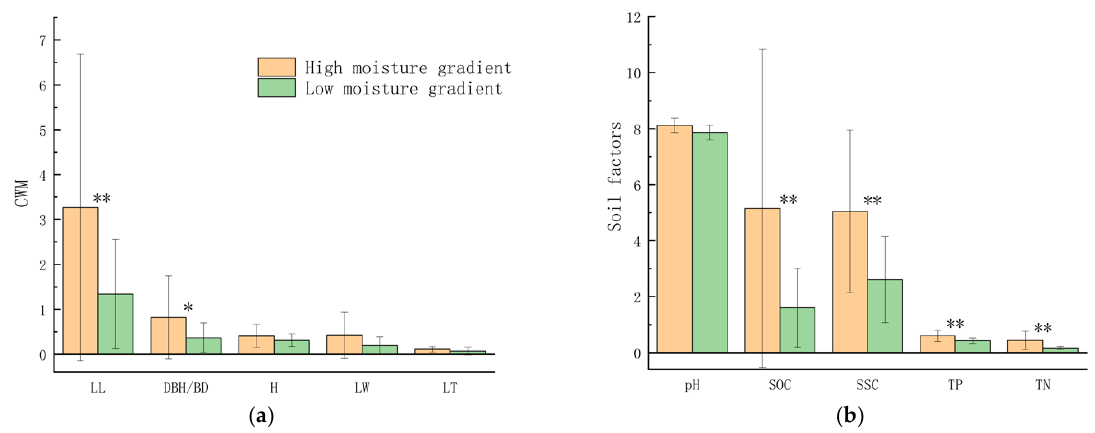
Figure 2. Soil physicochemical factors and community-weighted traits in different water gradients. ( a ) Community-weighted mean traits under different water gradients. ( b ) Soil factors under differ- ent water gradients. * Significant differences between high and low moisture gradient ( p < 0.05); ** extremely significant differences between high and low moisture gradient ( p < 0.01). Note: LL—leaf length, DBH/BD—diameter at breast height/base diameter, H—plant height, LW—leaf width, LT— leaf thickness.